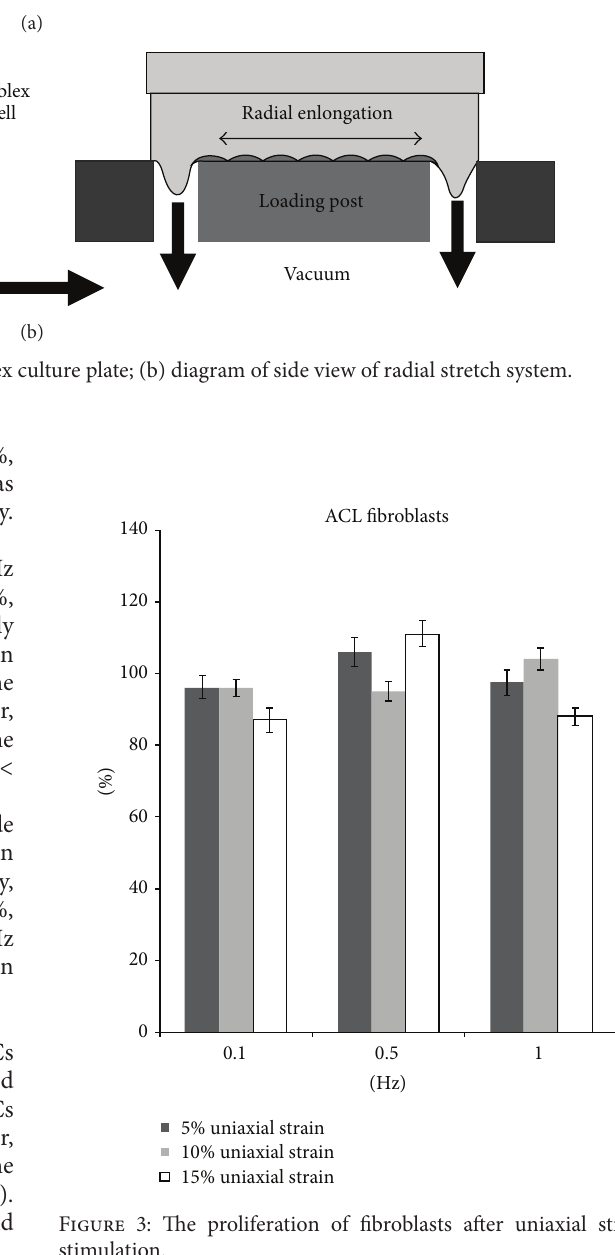
Figure 3: The proliferation of fibroblasts after uniaxial stretch